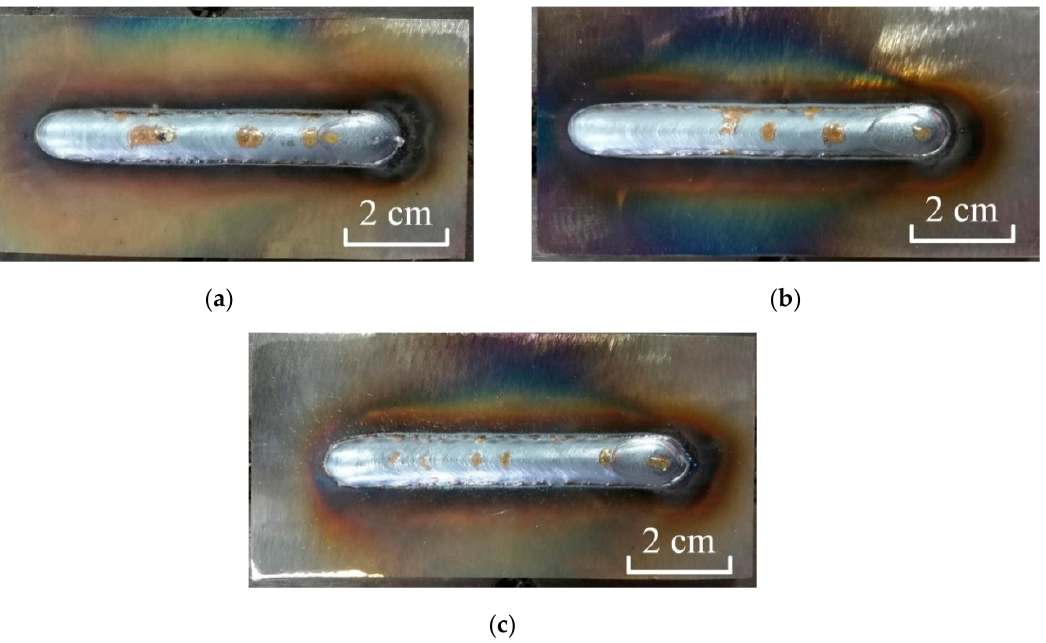
Figure 3. The surface appearance of beads with three typical modes of droplet transfer: ( a ) one drop per multiple pulses (ODMP); ( b ) one drop per pulse (ODPP); ( c ) multiple drops per pulse (MDPP).